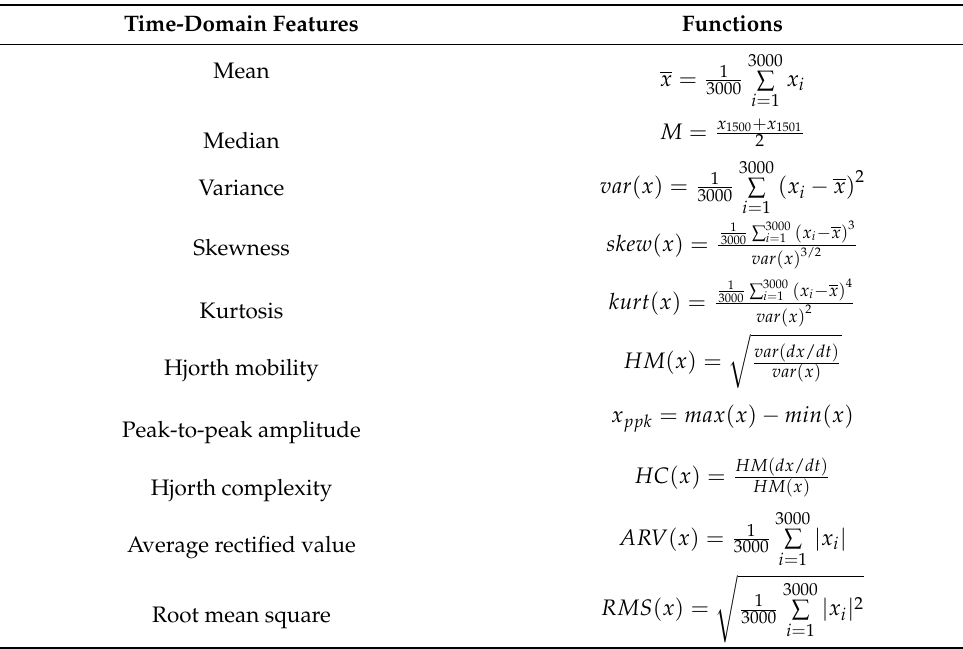
Table A1. Functions of time-domain features * 1